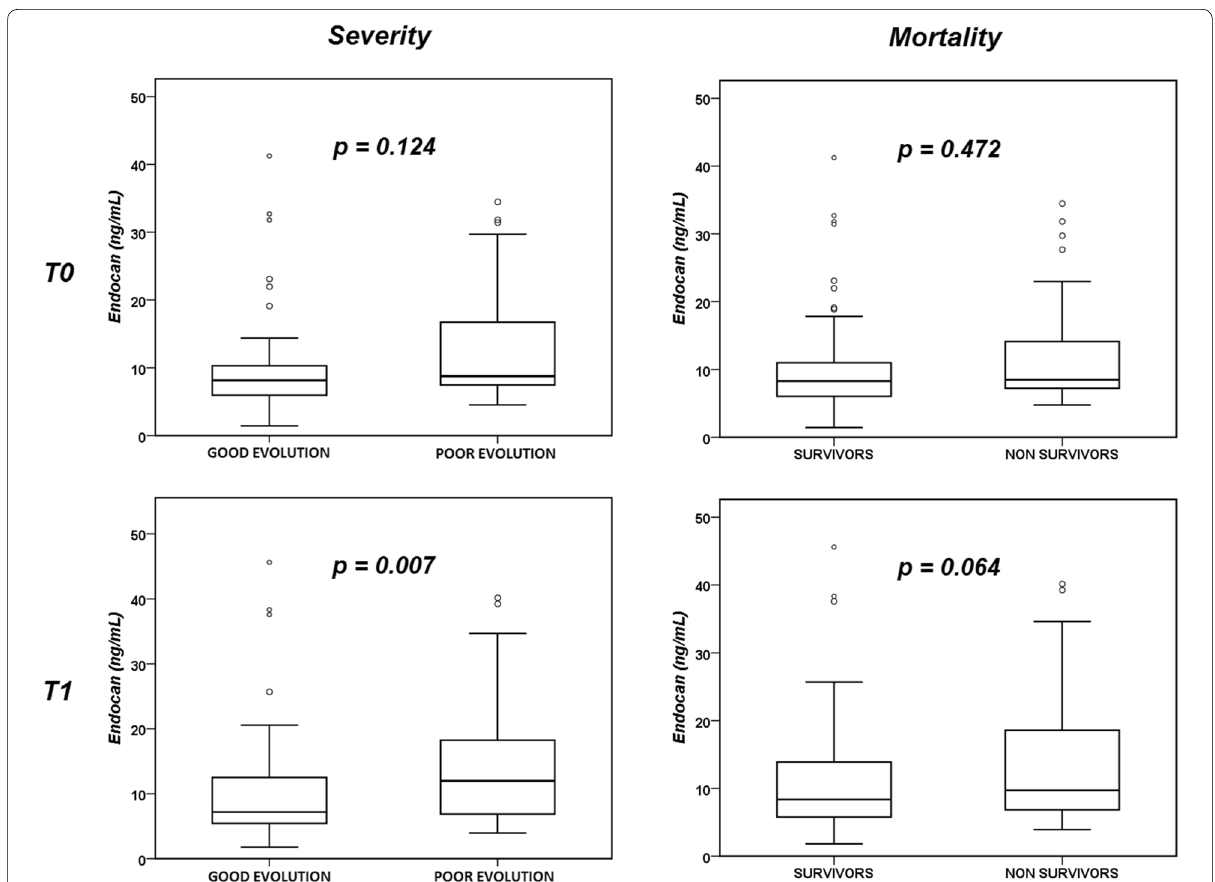
Fig. 2 Comparison of endocan concentrations at T0 and T1 in survivors and non‑survivors and in patients with poor and good